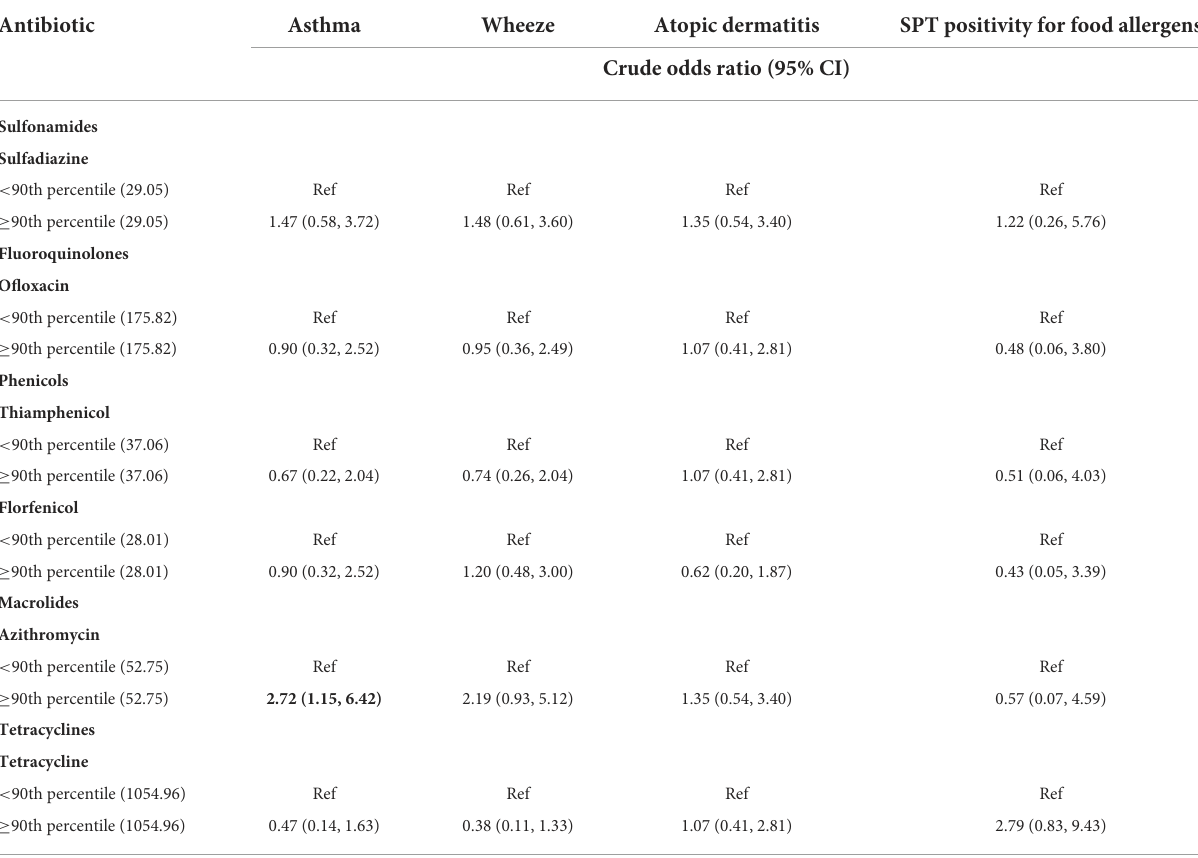
TABLE 5 Associations between maternal urinary antibiotic concentrations (ng/g creatinine) and allergic diseases and skin prick test positivity for food allergens (seven antibiotics with detection frequency below 50%). Antibiotic Asthma Wheeze Atopic dermatitis SPT positivity for food allergens Crude odds ratio (95%